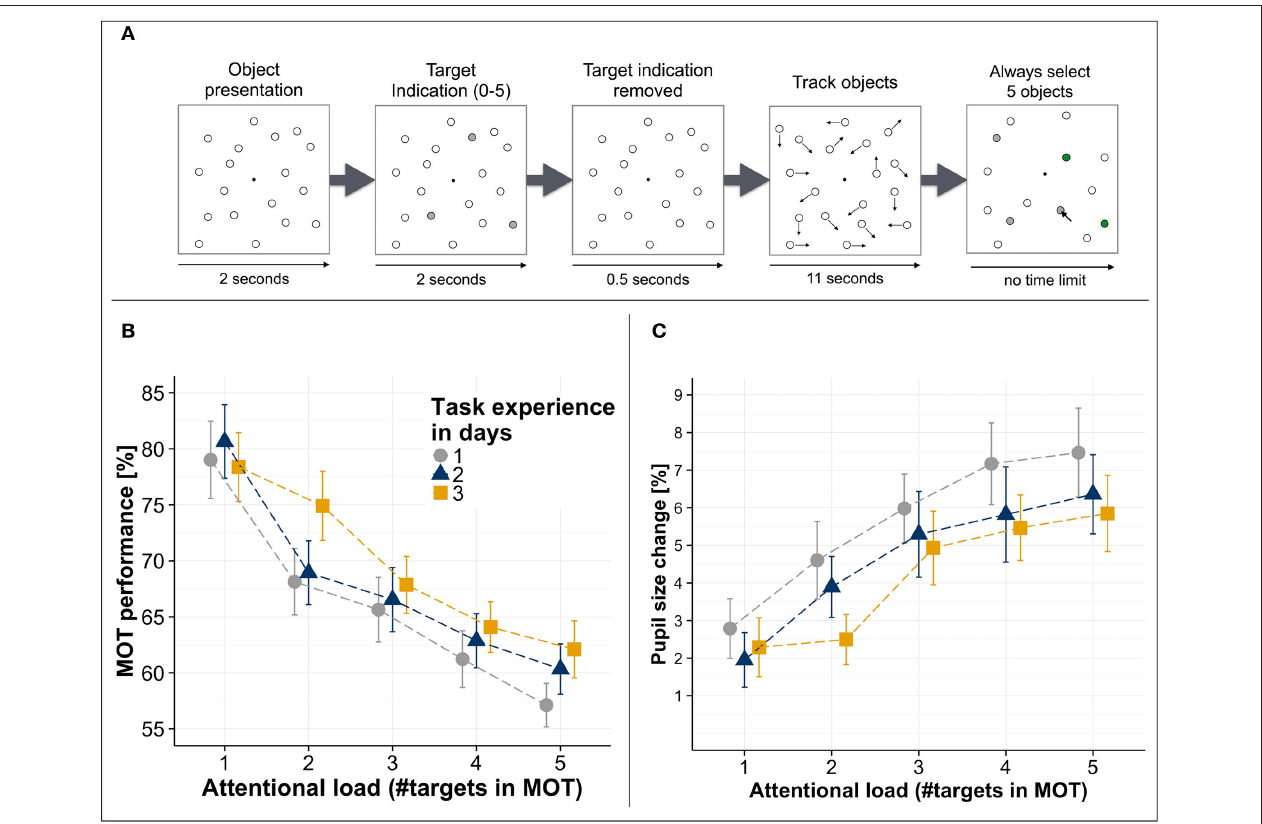
FIGURE 1 | (A) Multiple object tracking (MOT) task trial logic. First, several stationary objects are shown on a computer screen. A subset of these objects is indicated as targets (here in gray). Then, the target indication is removed (i.e., targets become indistinguishable from the other objects) and all objects start moving randomly across the screen. After several seconds, the objects stop moving and participants are asked to select the previously indicated target objects. (B) MOT performance (i.e., percent correct of selected targets) as a function of attentional load (i.e., number of tracked objects) and days of measurement. (C) Pupil size increases relative to a passive viewing condition (i.e., tracking no targets) as a function of attentional load and days of measurement. Error bars in (B,C) are standard error of the mean. All figures have been adapted from Wahn et al.